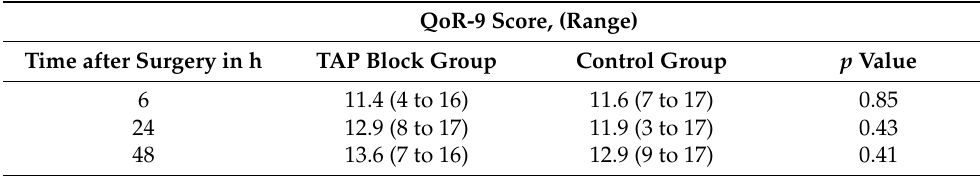
Table 2. Assessment of postoperative Quality of Recovery (QoR-9).